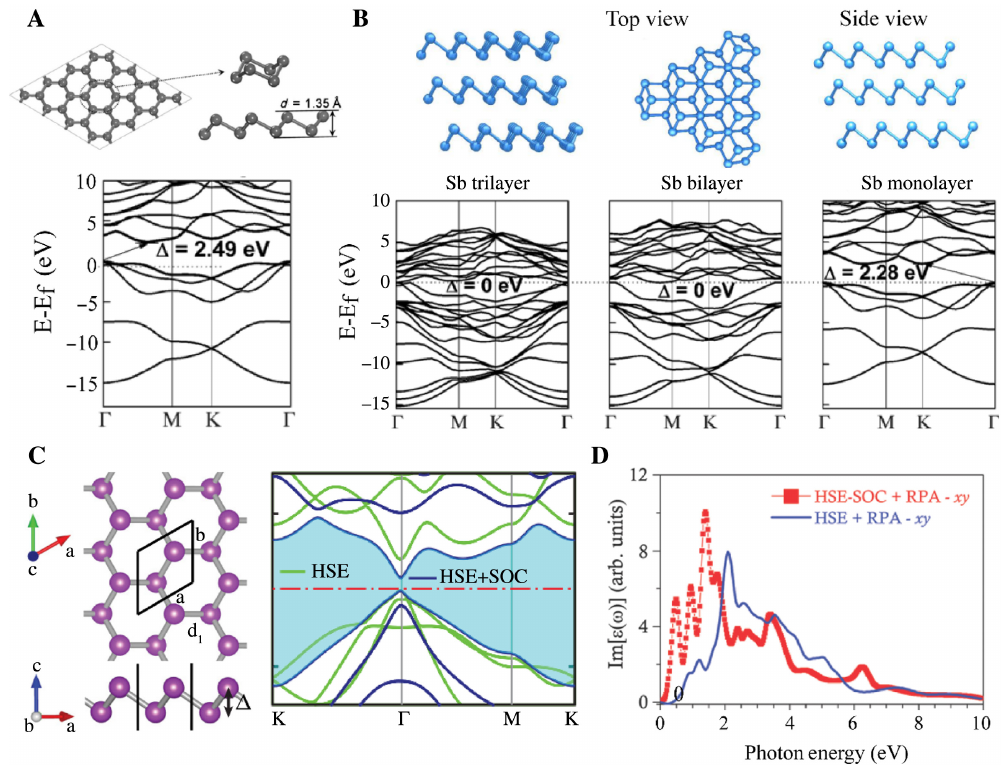
Figure 6: The atomic configuration and electronic structure of arsenene, antimonene, and bismuthene. (A) The atomic configuration and electronic band structure of monolayer arsenene. Reproduced with permission [85]. Copyright 2015, John Wiley and Sons. (B) The atomic configuration and layer-dependent band structure of antimonene. Reproduced with permission [85]. Copyright 2015, John Wiley and Sons. Reproduced with permission [86]. Copyright 2018, John Wiley and Sons. (C) The optimized atomic structure and electronic band structure of free-standing buckled honeycomb bismuthene calculated by HSE (hybrid functional) and HSE + SOC. Reproduced with permission [87]. Copyright 2016, American Physical Society. (D) The imaginary dielectric function of bismuthene calculated by HSE + RPA (random-phase approximation) and HES-SOC + RPA. Reproduced with permission [88]. Copyright 2019, The Royal Society of